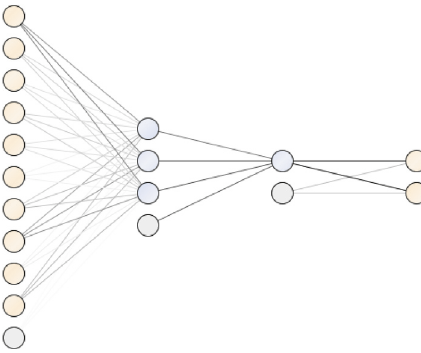
Figure 2: Neural network